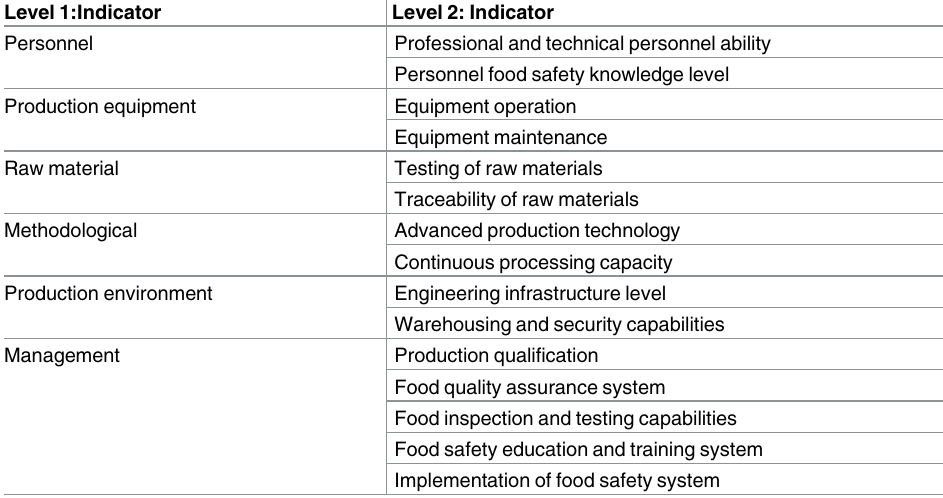
Table 1. Evaluation index for food safety